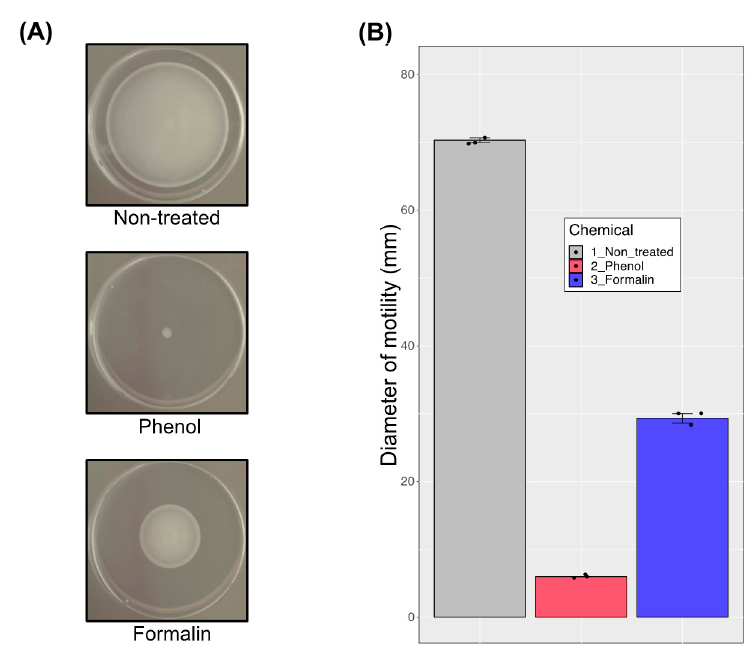
Figure 7. Movement of E. piscicida CK108 on solid BHI medium with the sub-ICs of phenol and formalin. ( A ) Representative cell motility from three independent assays. ( B ) Measurement of the swimming area. A total of n = 3 (biological triplicate) samples were applied. Error bars represent the standard deviation of the mean.